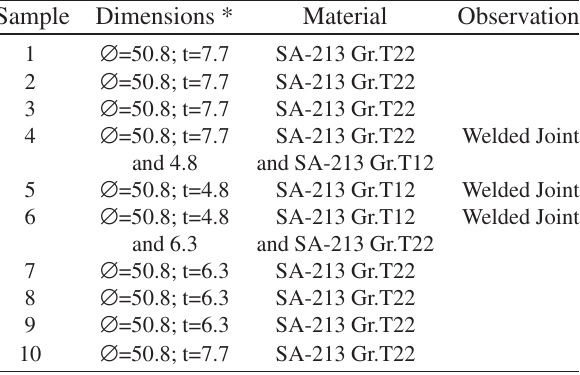
Table 1. Material specifications of the samples indicated on Fig. 2.